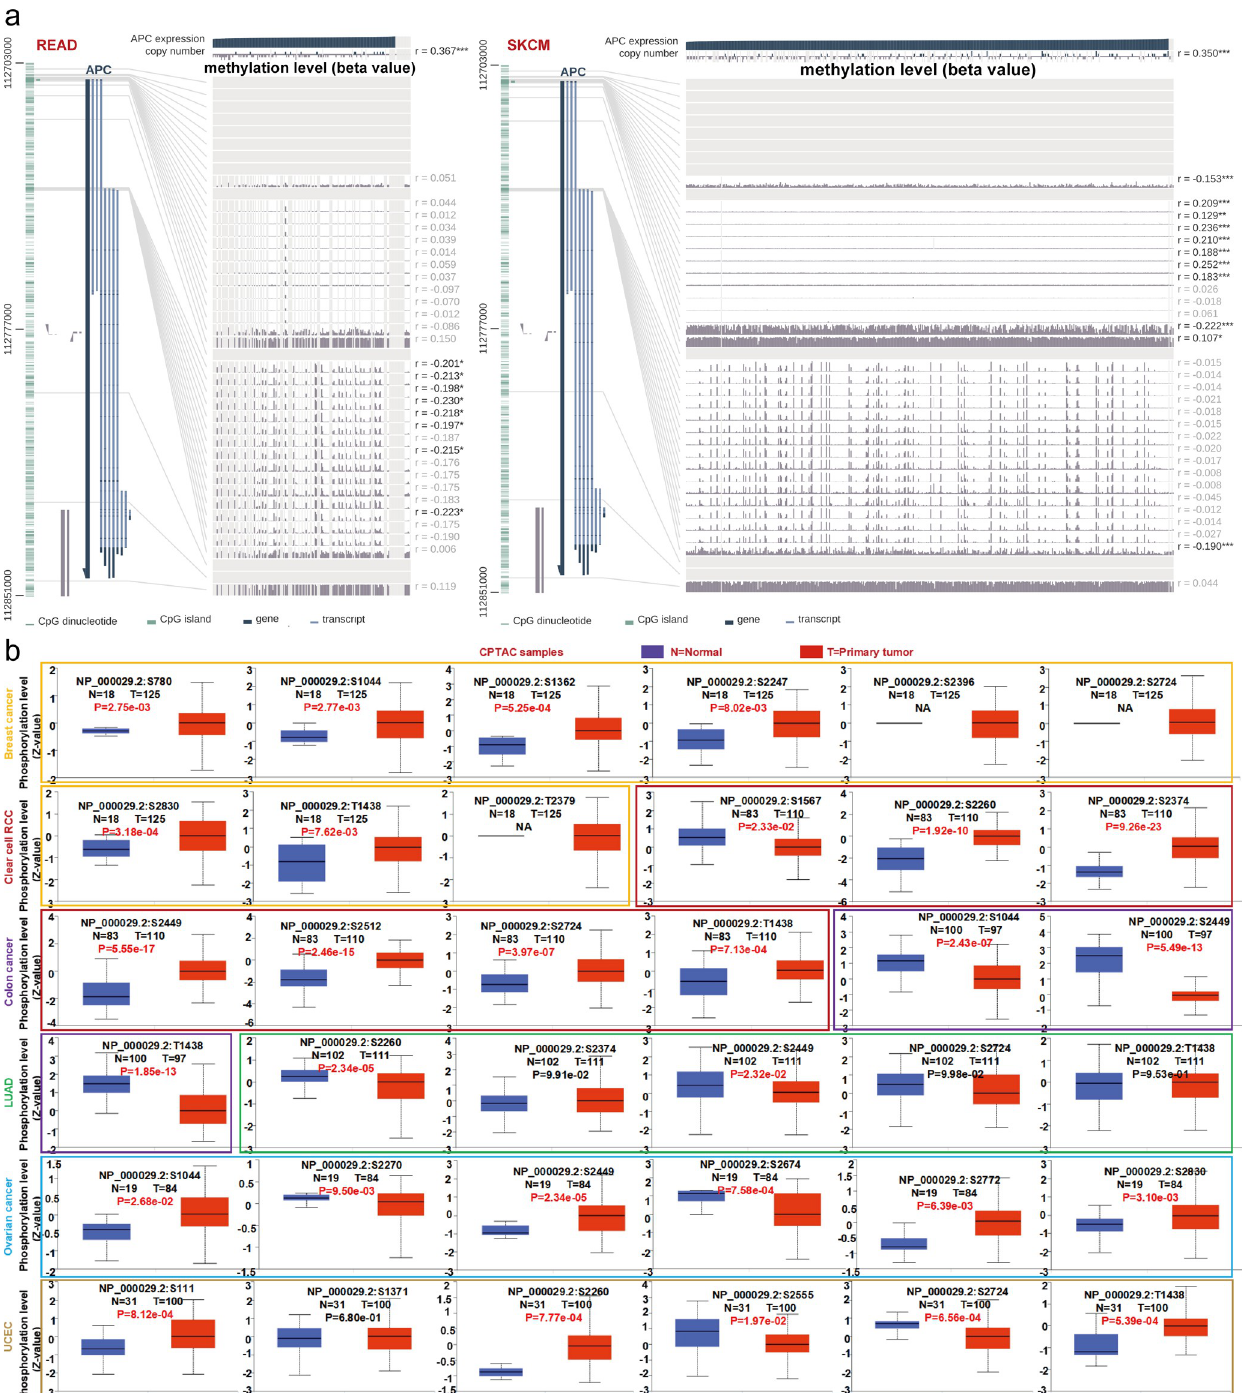
Fig 7. Association between APC DNA methylation and gene expression for the READ and SKCM cases of TCGA and phosphorylation analysis of APC protein in various tumors. (a) The DNA methylation level of APC of multiple probes was examined by using the MEXPRESS analysis. � P < 0.05; �� P < 0.01; ��� P < 0.001. (b) The expression level of APC phosphoprotein was examined with the UALCAN tool. READ, rectal adenocarcinoma; SKCM, skin cutaneous melanoma.